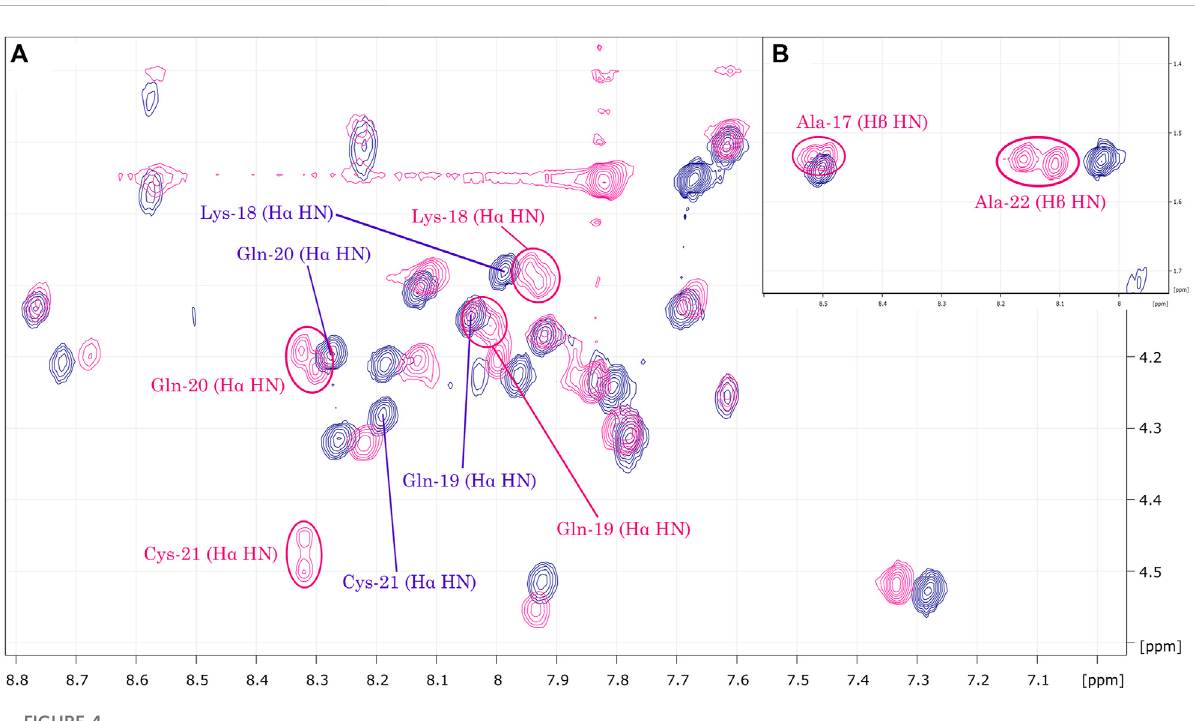
FIGURE 4 (A) Overlay of LyeTx I-b cys (dark blue) and LyeTx I-bPEG (pink) TOCSY contour maps. The highlighted correlations 22 and show that mPEG-MAL conjugation resulted in signal broadening or splitting for H α .HN and, for alanine residues, H β .HN correlations in LyeTx I-bPEG, while this was not observed for LyeTx I-b cys